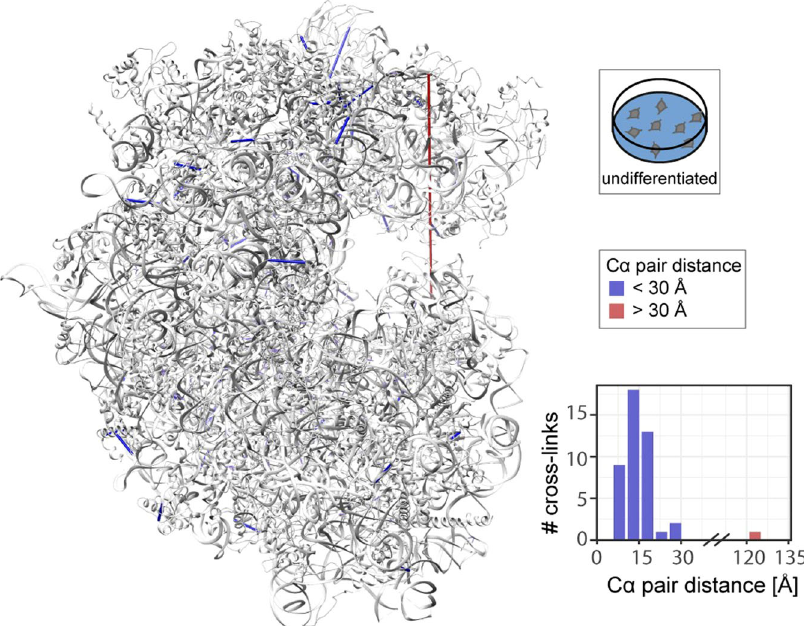
Fig. 6 Cross-links of ribosomal proteins identi fi ed in undifferentiated cells. SH-SY5Y cells were cross-linked using formaldehyde. Ribosomal cross-links observed in undifferentiated cells were visualised on the high-resolution structure of the ribosome (PDB ID: 4UG0 57 ). 43 cross-links have a C α distance < 30 Å (blue), one cross-link has a C α distance >30 Å (red). Figure generated using Supplementary Data